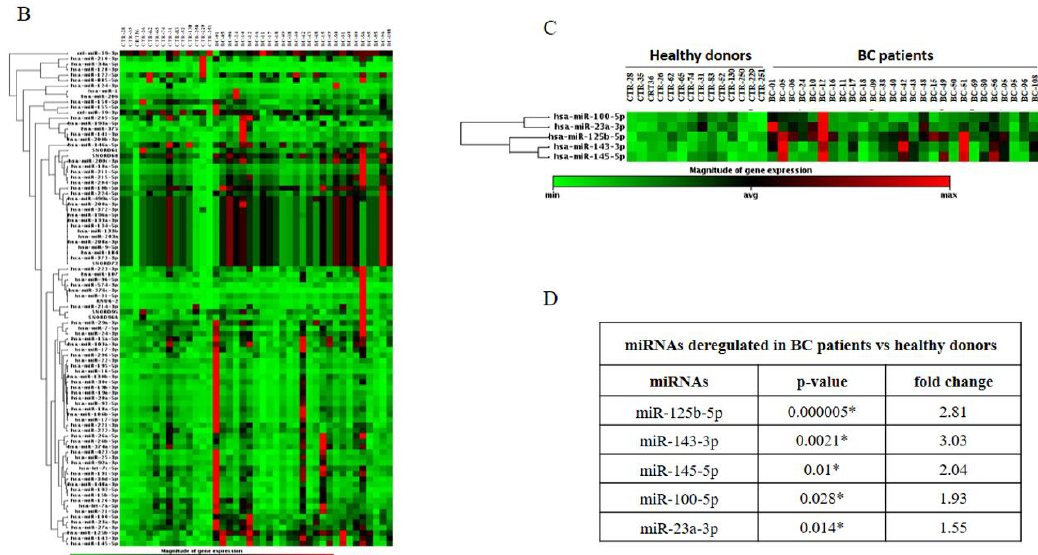
Figure 1. Study design for the identification of circulating miRNAs and protein biomarkers able to discriminate breast cancer (BC) patients from healthy donors ( A ). miRNA expression analysis in a set population of 14 healthy donors (CTR) and 27 BC subjects. Expression analysis of 84 miRNAs by using a 96-well miScript miRNA PCR Array ( B ). *miRNAs significantly upregulated ( p < 0.05) in BC patients vs. healthy donors ( C , D ).